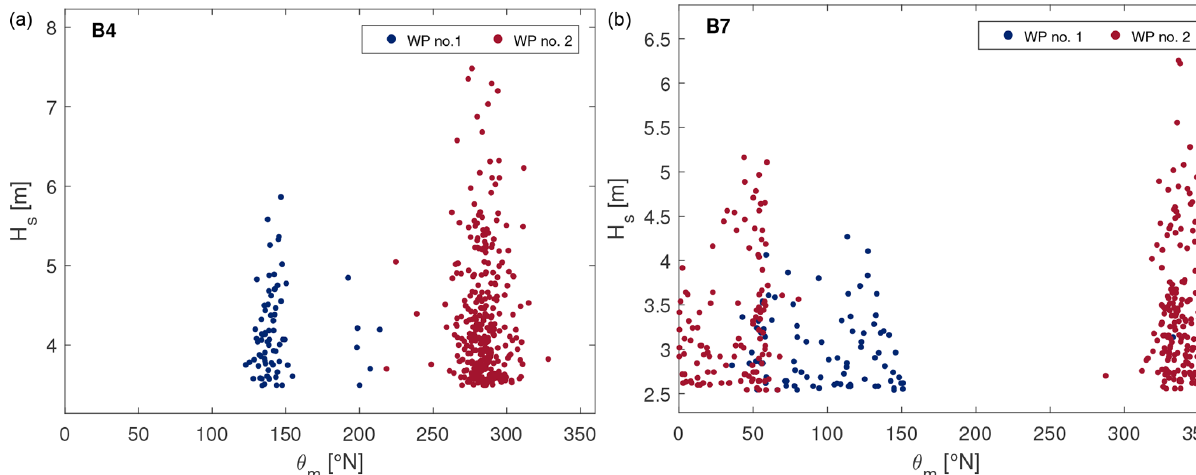
Figure 12. Scatterplot of H s and θ m due to different WP. (a) B4; (b) B7.